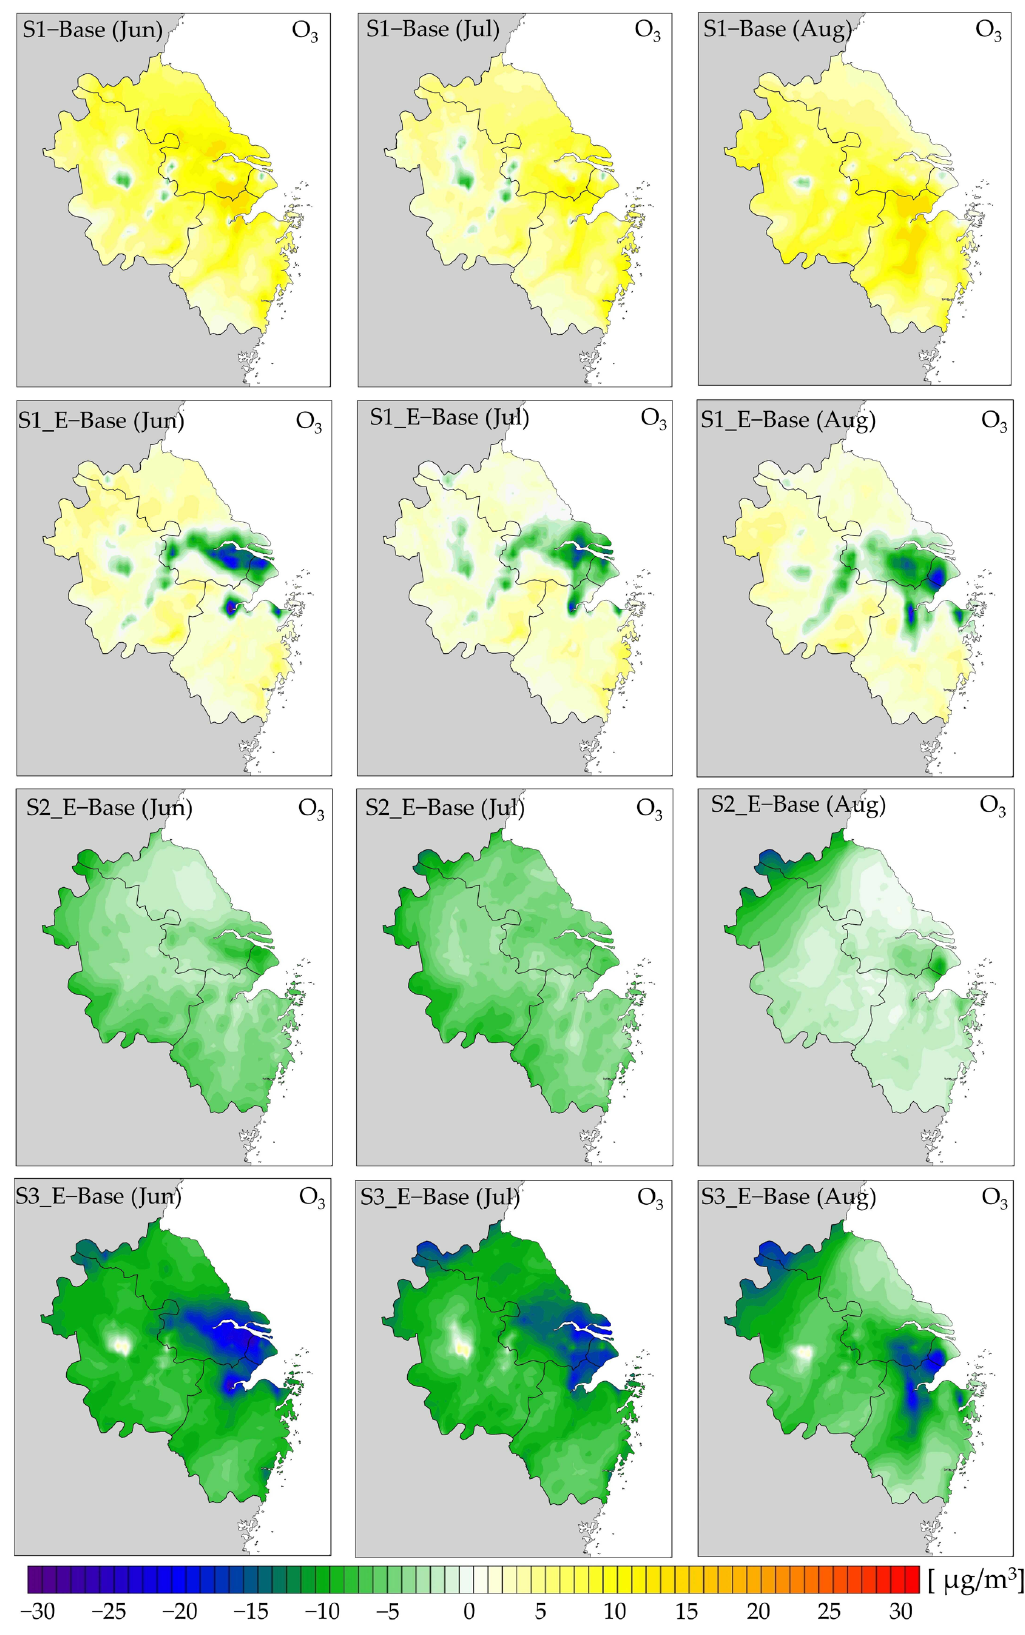
Figure 4. Spatial distributions of monthly average O 3 concentration change values under the 4 control scenarios relative to the base case over the YRD region in June (Jun), July (Jul) and August (Aug), 2025.